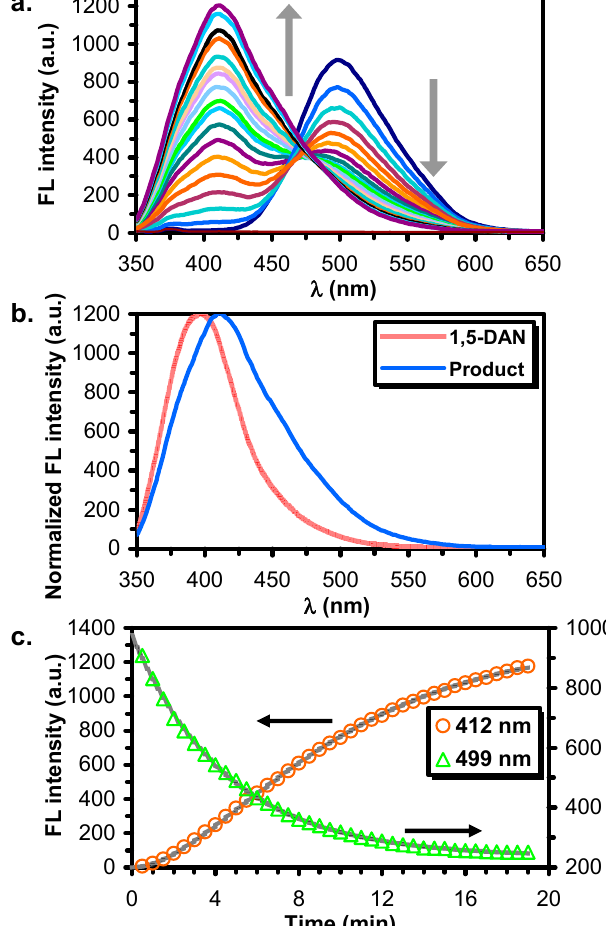
Figure 3. Evolution of the emission spectra during the reaction of 1,5-ICAN with the mixture of water / i PrOH and HgCl 2 ( a ). The normalized fluorescence (FL) intensity of 1,5-DAN and that of the final reaction product ( b ) and the variations of the fluorescence intensities recorded at λ = 412 nm and 499 nm at 30 s intervals ( c ). The symbols show the experimental data, while the black solid lines represent the fitted curves by Equations (4) and (5). Experimental conditions: [H 2 O] = 27.8 mol / L (~50% (V / V)), [1,5-ICAN] = 2.5 × 10 − 6 mol / L, [HgCl 2 ] = 1.2 × 10 − 3 mol / L and T = 25 ◦